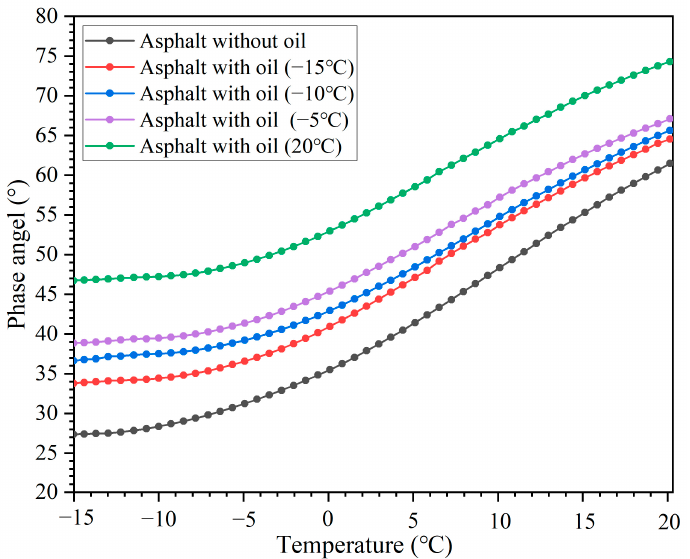
Figure 14. Phase angel of asphalt binder after loading with 64,000 cycles under different service temperature conditions.